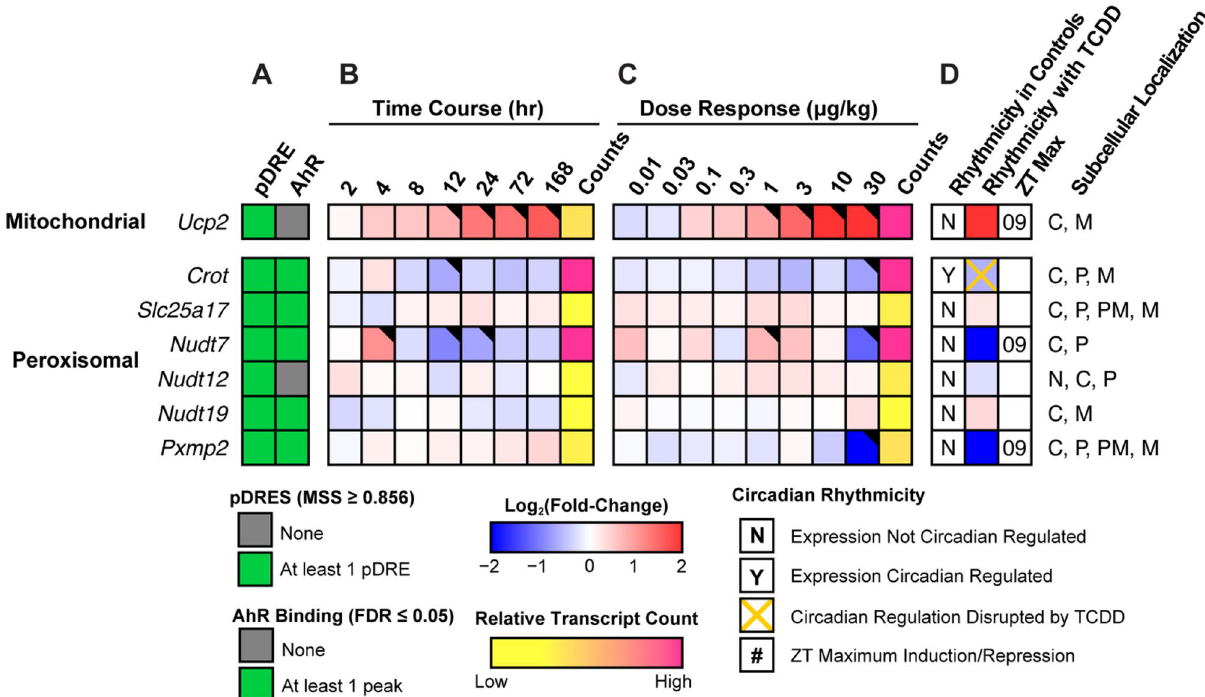
Figure 7. Mitochondria and peroxisomal fatty acid and CoASH transport. Differential expression of genes associated with mitochondrial and peroxisomal fatty acid and CoASH transport assessed by RNA-seq. Mouse Genome Informatics (MGI) official gene symbols are used. ( A ) The presence of putative dioxin response elements (pDREs) and AHR genomic binding at 2 h. ( B ) Time-dependent expression following a single bolus dose of 30 μg/kg TCDD (n = 3). ( C ) Dose-dependent gene expression assessed following oral gavage every 4 days for 28 days with TCDD (n = 3). ( D ) Diurnal regulated gene expression denoted with a “Y”. An orange ‘X’ indicates abolished diurnal rhythm following oral gavage with 30 μg/kg TCDD every 4 days for 28 days. ZT indicates statistically significant (P1( t ) > 0.8) time of maximum gene induction/repression. Counts represent the maximum number of raw aligned reads for any treatment group. Low counts (< 500 reads) are denoted in yellow with high counts (> 10,000) in pink. Differential gene expression with a posterior probability (P1( t )) > 0.80 is indicated by a black triangle in the top right tile corner. Protein subcellular locations were obtained from COMPARTMENTS and abbreviated as: cytosol (C), mitochondrion (M), nucleus (N), peroxisome (P), and plasma membrane (PM). The heatmap was created using R (v4.0.4).